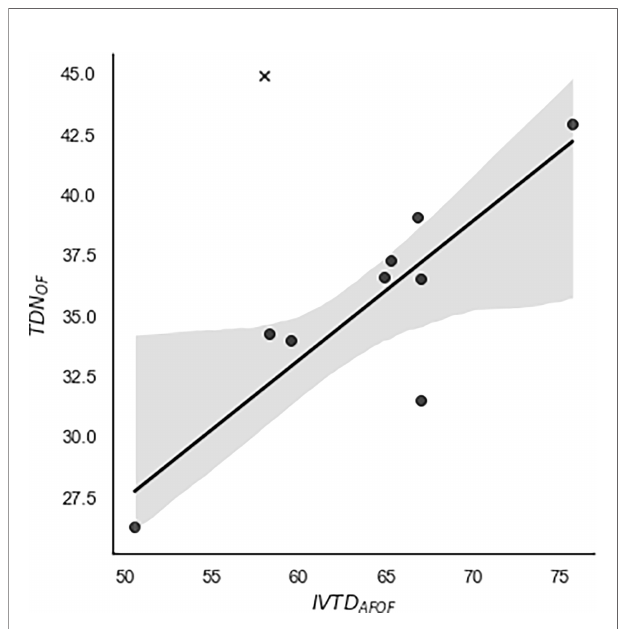
FIGURE 2 | Regression of calculated total digestible nutrients (TDN OF ; non- oil basis) against observed in vitro true digestibility (IVTD AFOF ; ash-free, non-oil basis) of alfalfa cube and 9 cultivars of CBD-extracted industrial hemp in fl orescence. TDN OF values were calculated using a modi fi ed version of the summative equation system proposed by Weiss et al. (1992). To obtain IVTD AFOF measurements, hemp samples were incubated in an ANKOM Daisy II Incubator for 48 h following the manufacturer ’ s instructions. The correlation between IVTD AFOF and TDN OF was moderately strong (Adj. R 2 = 0.70) and described using the equation TDN OF = 0.5748(IVTD AFOF ) - 0.3502. Hemp cultivars = (cid:129) . Alfalfa Cube =